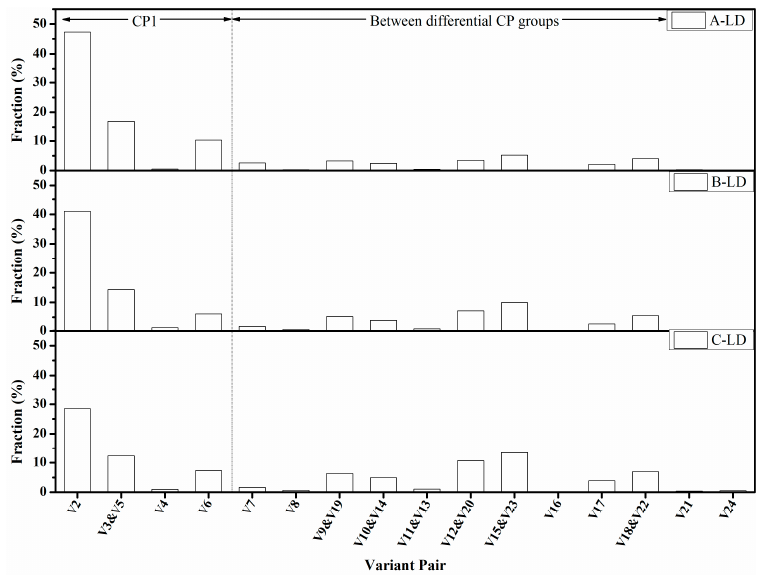
Figure 12. The fraction of the variant pairs constituting the angle boundaries in these specimens in the longitudinal direction.